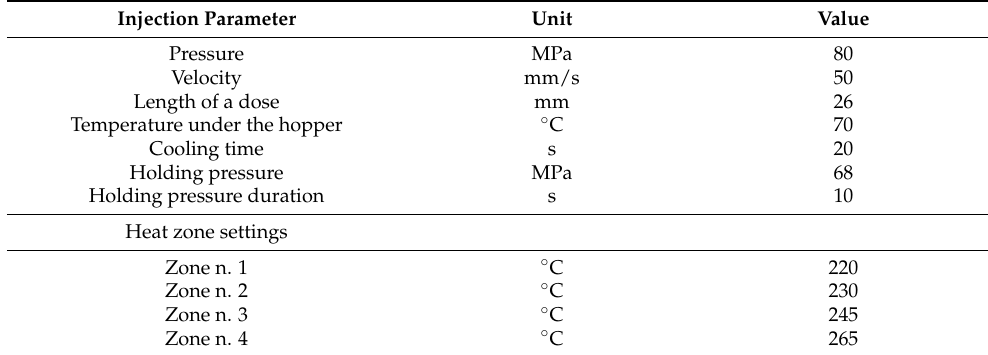
Table 2. Technological parameters of the injected